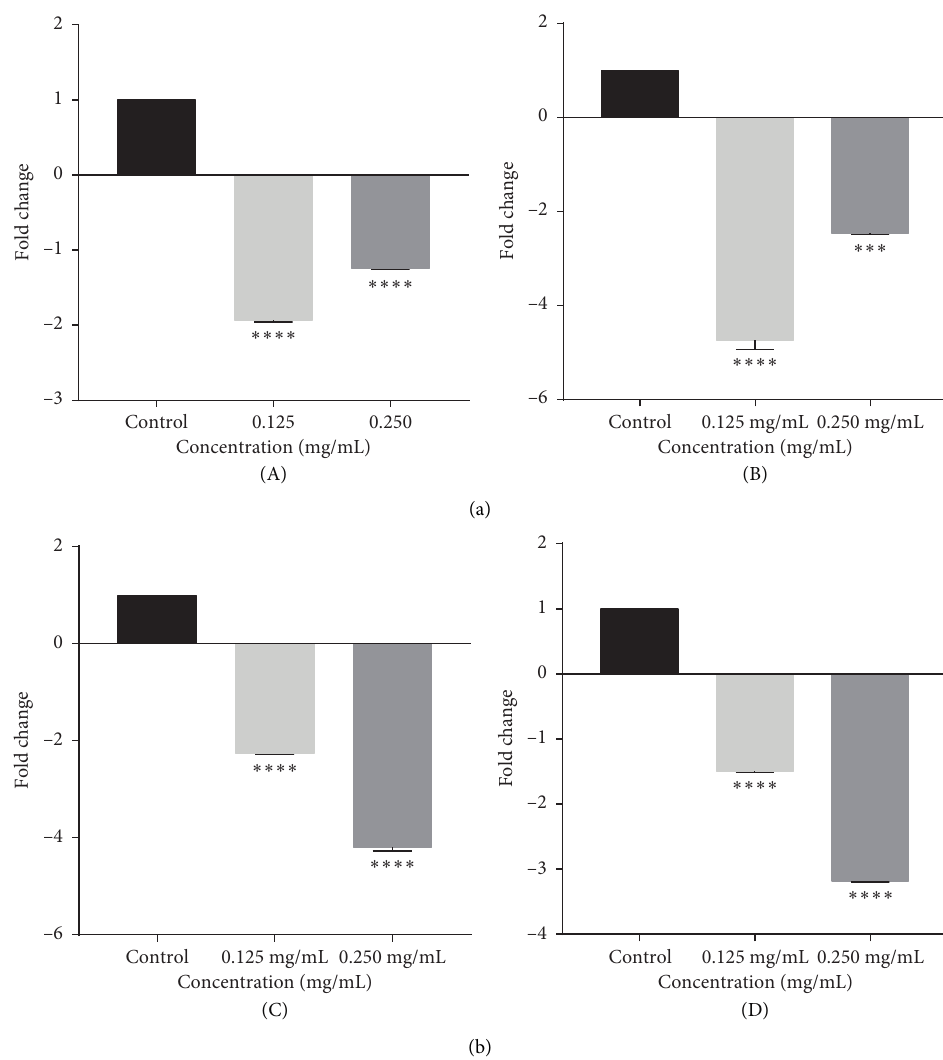
Figure 4: (a) Expressions of hypoxia-related genes ((A) HIF-1 α and (B) HIF-2 α ) illustrated as fold changes in HA-GA-NP-treated bCSCs. ∗∗∗∗ P < 0 . 0001 compared with the untreated controls. (b) Expressions of notch pathway-related genes ((C) DLL1 and (D) Jagged1) il- lustrated as fold changes in HA-GA-NP-treated bCSCs. ∗∗∗∗ P < 0 . 0001 compared with the untreated